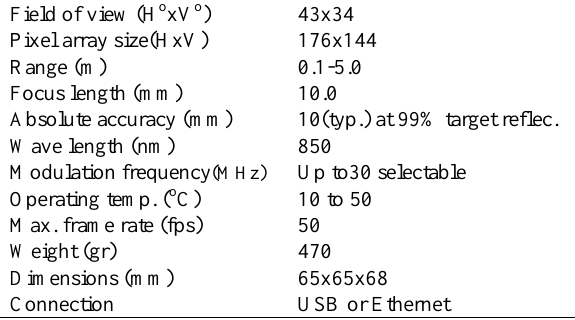
Table 1. Technical specifications of SR4000 camera (URL-1)